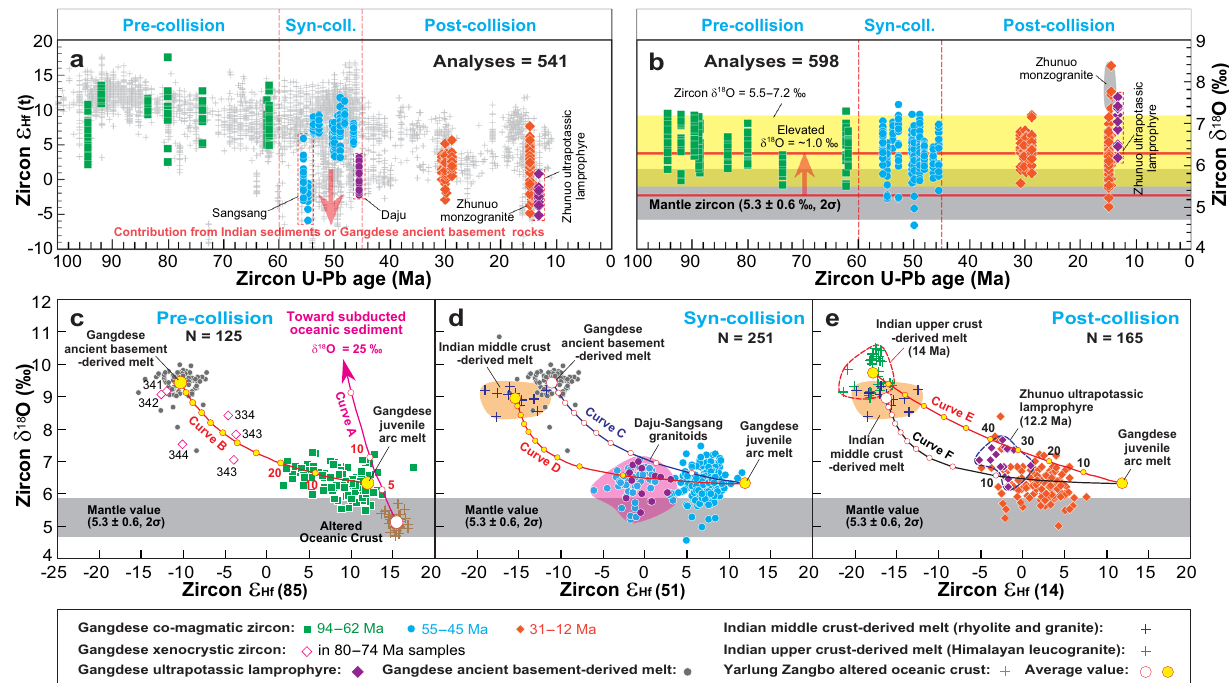
value:Indian upper crust-derived melt (Himalayan leucogranite): Gangdese ancient basement-derived melt: Average Fig. 4 | Evolving zirconHf-Oisotopecompositionsofmagmaticrocksfromthe subducted sediment, and curves D, E, and F of binary mixing in d and e linking the Gangdese Batholith. a Temporal change in zircon ε Hf (t) showing that some syn- Gangdese juvenile arc melt with the Indian middle or upper crust-derived melts andpost-collisionalsampleshavelower,moreenrichedvalues. b Temporalchange denote recycling of Indian supracrustal material. The entire zircon ε Hf (t) dataset from the Gangdese Batholith (gray crosses) is plotted in a as background. All Hf inzircon δ 18 Oshowingalimited rangeof5.5 – 7.2 ‰ (yellowband)withanumberof exceptions with values above 7.2 ‰ , particularly among Miocene post-collisional isotope ratios were age-corrected to 85Ma in c , 51Ma in d , and 14Ma in e . Small samples. The horizontal thick red lines indicate the ~1 ‰ systematic increase in circles on the curves represent 10% AFC increments except for the one circle zircon δ 18 O of the 100 – 30Ma samples relative to mantle values (5.3±0.6 ‰ , 2 σ 39 ), labeled 5% close to the Gangdese juvenile arc melt. Number beside red diamonds suggesting ~5% subducted sediment addition (Curve A in c ). c – e δ 18 O versus ε Hf (t) (e.g., 343) in c represents the age of the xenocrystic zircon. All available data of for zircons from the Gangdese samples. Curves B and C of binary mixing in c and zircon Hf-O isotopes in a and b are measured at the same spots or the same d linking the Gangdese juvenile arc melt with the Gangdese ancient basement- domains used for age determinations of concordant individual analyses (Supple- derivedmeltsuggestcrustalassimilation.CurvesAofbinarymixingin c linkingthe mentary Table 4). The methods for selecting Hf abundances and Hf-O isotopic altered oceanic crust with the subducted oceanic sediment indicate recycling of compositions of each end-member are given in Supplementary